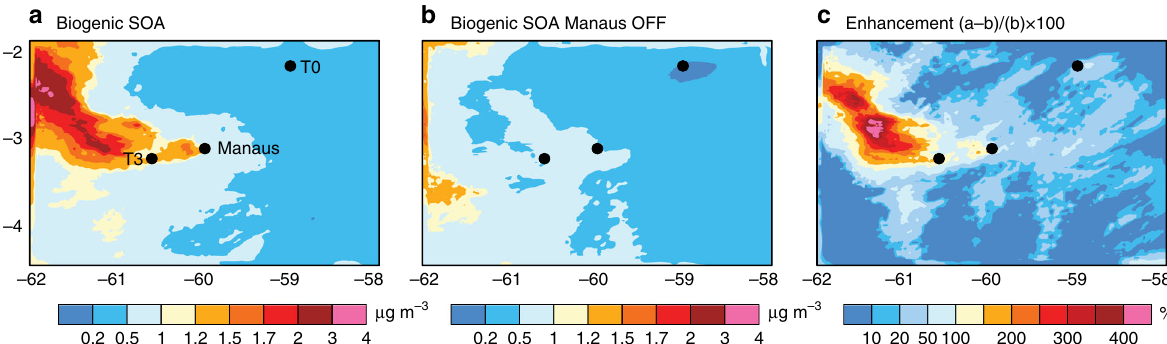
Fig. 2 WRF-Chem simulated concentrations of biogenic SOA in the presence and absence of Manaus emissions. a Biogenic SOA when all emissions are on b Biogenic SOA when biogenic volatile organic compound (VOC) emissions are on but Manaus (anthropogenic) emissions are turned off c Biogenic SOA enhancement (%) calculated from the two simulations with Manaus emissions turned on/off i.e. (a – b)/b× 100. WRF-Chem predictions are at ~500